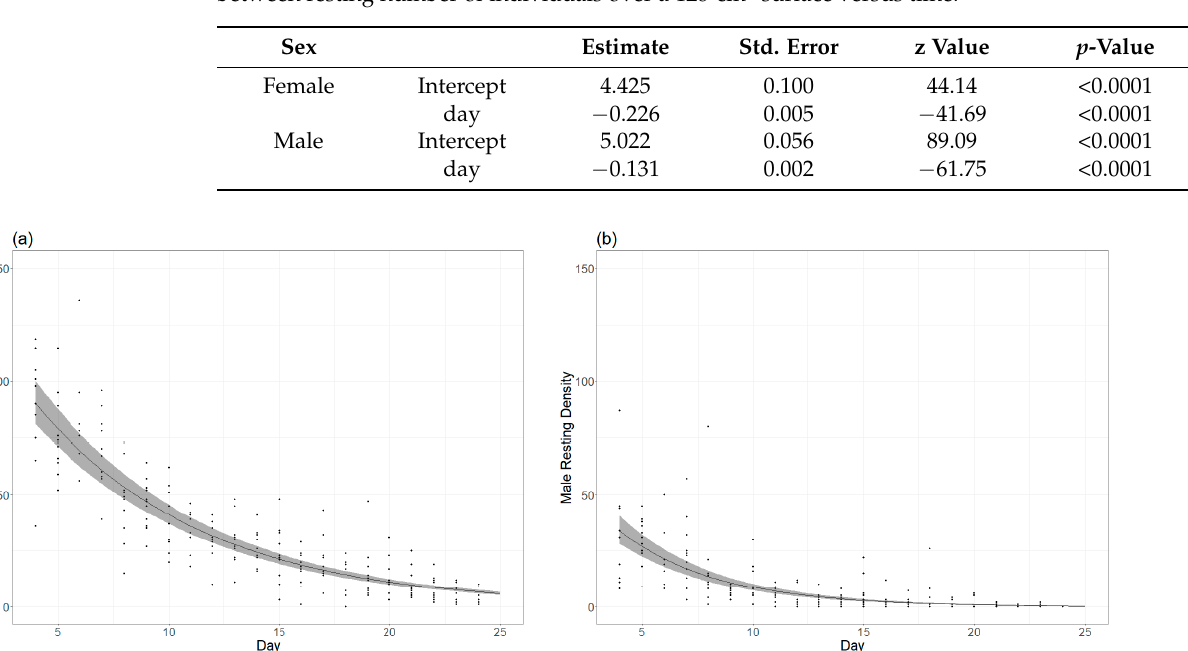
Figure 5. ( a ) Survival rate of females over time. ( b ) Survival rate of males per day.